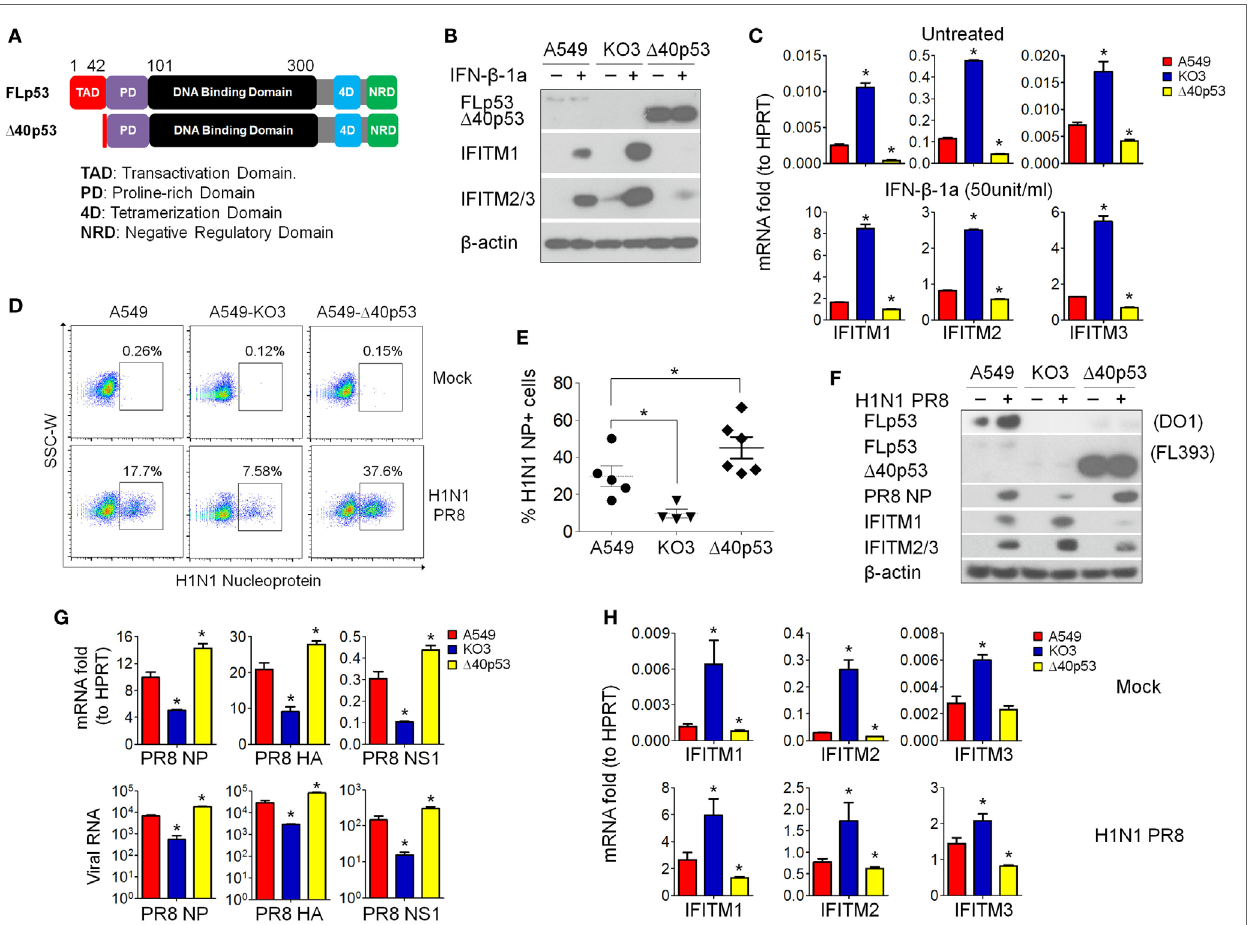
FigUre 8 | p53 regulates interferon-induced transmembrane proteins (IFITMs) independent of its transcriptional activity. (a) Schematic presentation of modular structures of full-length p53 and short isoform Δ 40p53 proteins. (B) Western blot analysis of p53 (detected by antibody FL393, sc-6243), IFITM1, and IFITM2/3 expression levels in interferon- β 1a (IFN- β -1a) treated p53WT A549, A549-KO3, and A549- Δ 40 cells. β -actin blotting was used as a loading control. (c) Real- time quantitative PCR (RT-qPCR) analysis of IFITMs mRNA expression in IFN- β -1a treated p53WT A549, A549-KO3, and A549- Δ 40 cells. * p < 0.05. (D) A549, A549-KO3, and A549- Δ 40 were infected with IAV [multiplicity of infection (MOI) = 0.001] and after 24 h were analyzed for IAV nucleoprotein (NP) expression by flow cytometry. The populations of NP-positive cells were boxed and their percentages shown. (e) Percentage of NP-positive cells in IAV- (MOI = 0.001) -infected p53WT A549, A549-KO3, and A549- Δ 40 cells quantified from fluorescence microscopy images: between 4 and 6 areas were randomly selected for image capture and the percentages of NP-positive cells within the total cell population were calculated. * p < 0.05. (F) Western blot analysis of p53 (detected by both DO-1, sc-126 and FL393, sc-6243), IAV NP, IFITM1, and IFITM2/3 protein expression in p53WT A549, A549-KO3, and A549- Δ 40 cells following IAV infection (MOI = 0.001). β -actin blotting was used as a loading control. (g) RT-qPCR measurement of viral RNAs encoding NP, hemagglutinin (HA), and non-structural protein 1 (NS1) genes detected either in IAV- (MOI = 0.001) infected cells (top) or from the culture supernatant (bottom). * p < 0.05. (h) RT-qPCR analysis of IFITM1, IFITM2, and IFITM3 gene expression in mock- or IAV-infected p53WT A549, A549-KO3, and A549- Δ 40 cells. * p <